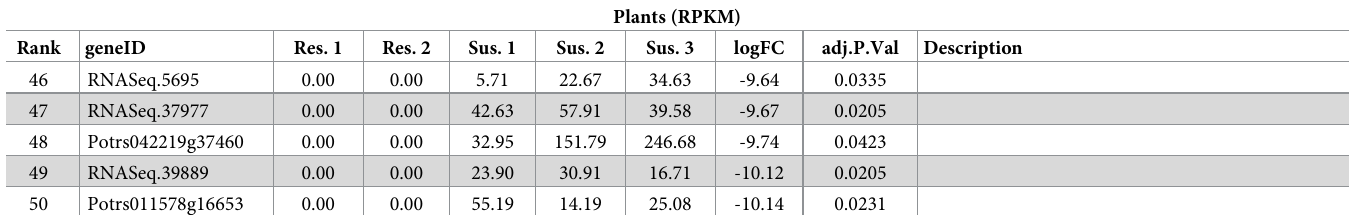
The Top 30 upregulated and downregulated genes identified in resistant genotypes are dis- played in Tables 2 and 3 respectively. Specifically, some of the highly upregulated genes in RG were characterized as Dirigent protein 10, GATA transcription factor, RuBisCO reductase (chloroplastic), Zinc finger protein, Cationic peroxidase 2, Probable mannitol dehydrogenase, Flavin-dependent oxidoreductase, Auxin response factor, Bidirectional sugar transporter, thia- mine thiazole synthase, and DNA3-methyladenine. One gene of interest is the copper transport protein found to be upregulated in resistant genotypes. Annotation information for the top downregulated genes in RG is limited but includes a DnaJ chaperone protein, phosphomethylpyrimidine synthase (chloroplastic), and leucine zipper protein (Table 3).